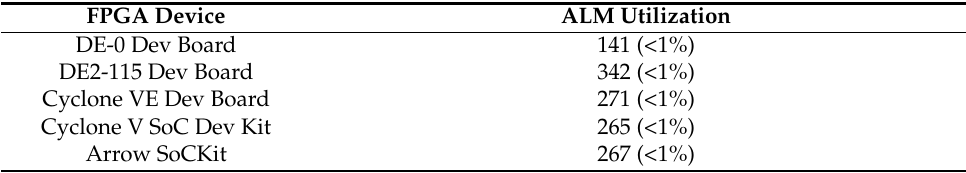
Table 4. Resource usage for various FPGA